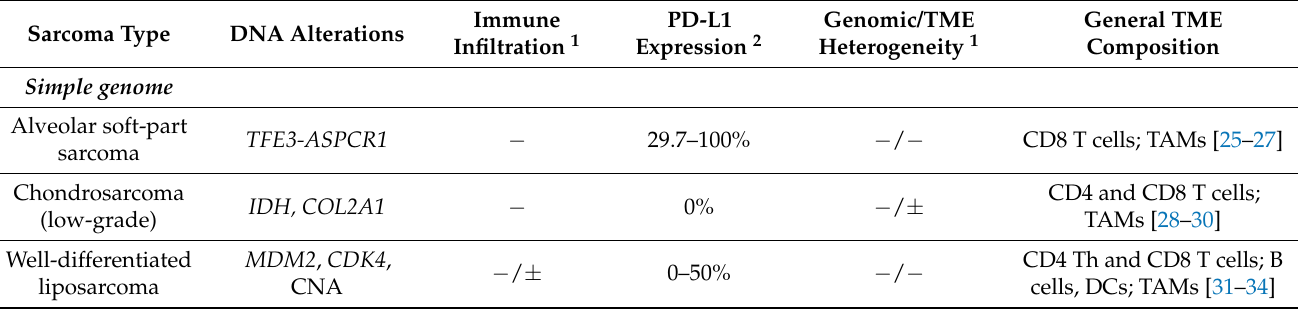
Table 1. An overview illustrating TME characteristics of a selection of simple and complex genome sarcoma types. Sarcoma